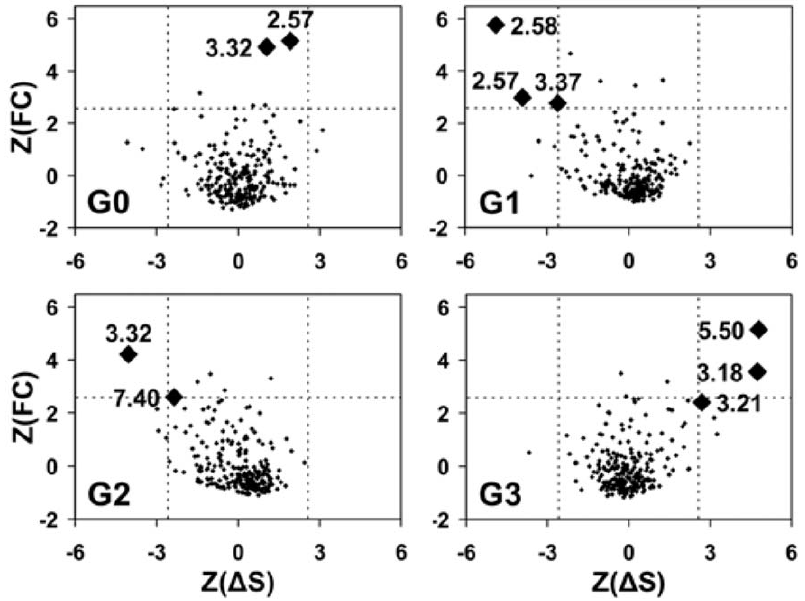
Figure 7. Sequence analysis of the four MDS groups. For each group G i ( i = 0 to 3) and each position l of the alignment, the Z -score of the correlation function, FC ( l ), is plotted as a function of the Z-score of the entropy difference D S ( l ) between group G i and its complement G iC . The dashed lines correspond to Z -scores of 2.58 (99% confidence level).